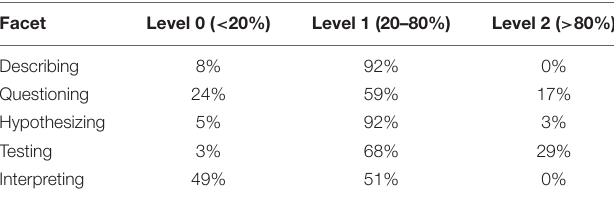
TABLE 6 | Descriptive for observation competency